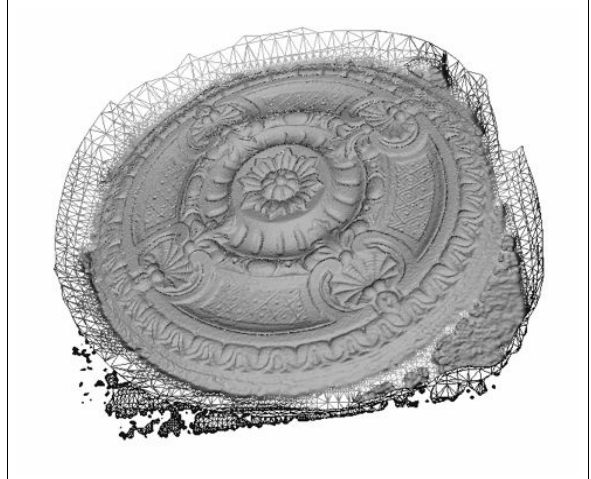
Figure 6: Reconstructed surface of a marble artifact. Please ob- serve how the fine details are